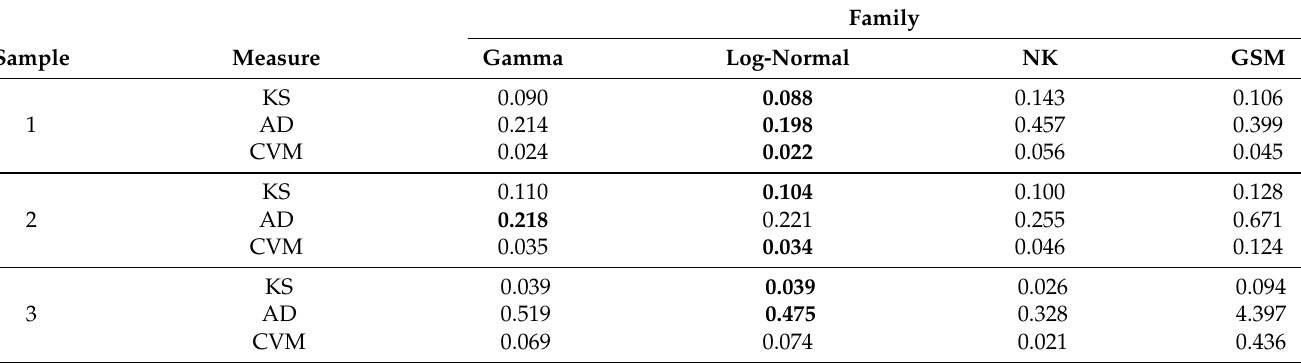
Table 5. Goodness-of-fit statistics for fitting mixture of gamma, mixture of log-normal, GSM, and NK models to samples 1 and 2 in ungrouped case. The number of components used for fitting the log-normal and gamma mixture models to samples 1 and 2 are 2 and 3, respectively. The number of components used for fitting GSM model to both samples is